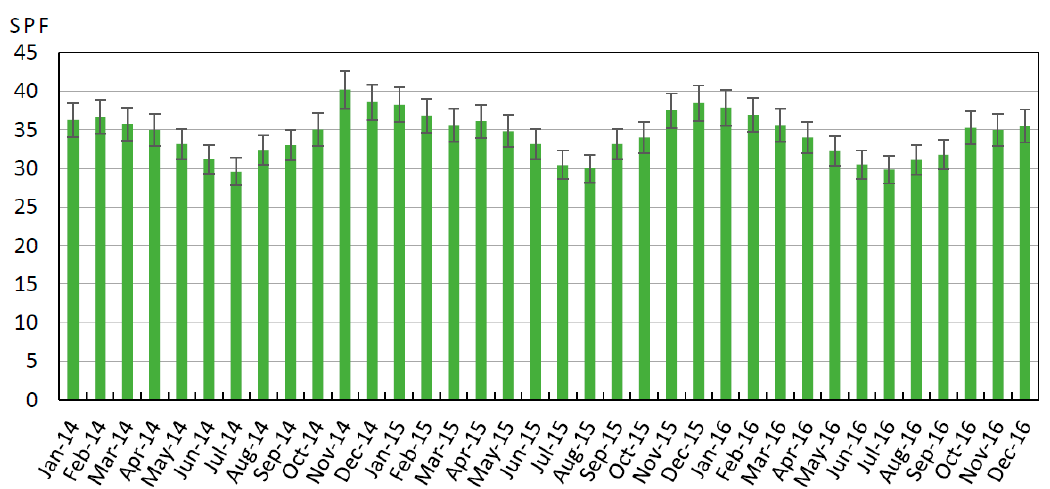
Figure 20. Monthly SPF 0 values based on Annex 52 boundaries.